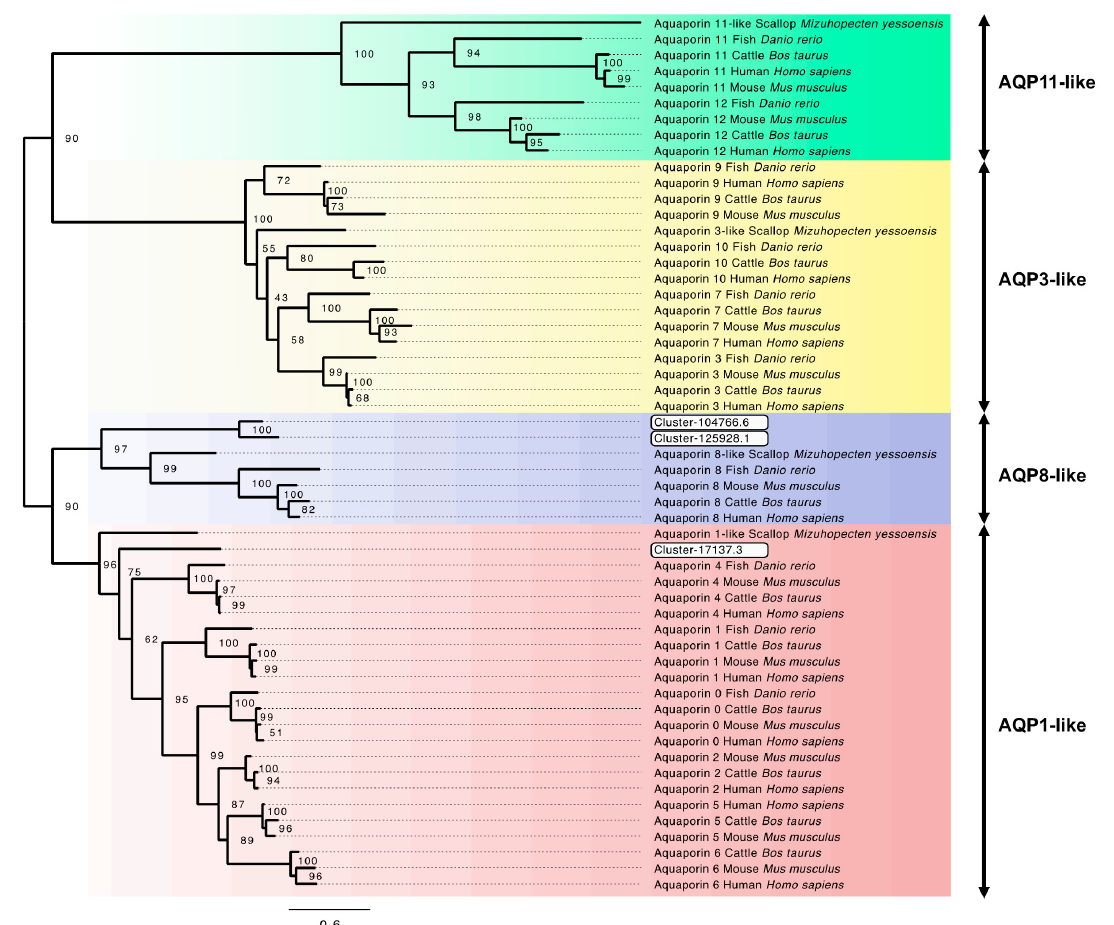
Figure 4. Maximum likelihood unrooted phylogeny of aquaporin genes AQP0-12 from GenBank including human, mouse, cattle, fish and mollusc (for GenBank assession numbers, see Table S1), and blue mussel ( M. edulis ) putative aquaporins transcripts identified in this study (highlighted in white boxes). Bootstrap values at nodes. AQP2 , AQP5 and AQP6 orthologues are absent in the zebrafish Danio rerio . The scallop, Mizuhopecten yessoensis aquaporin genes are predicted from genome analysis; therefore, only a single sequence representative from each for the four aquaporin classes has been